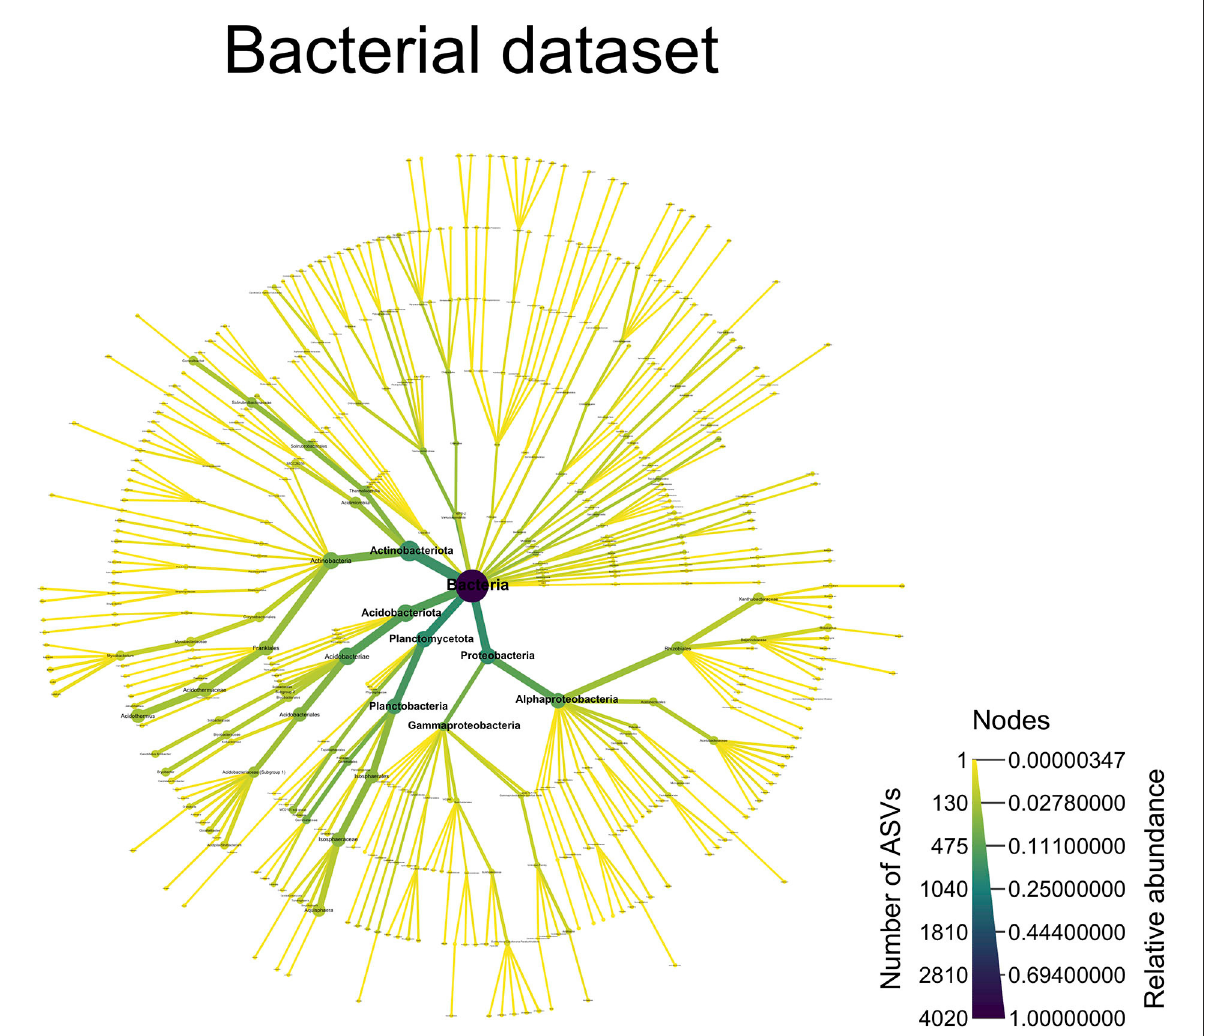
FIGURE6 A taxonomy overview of the bacterial community. This figure displays all of the bacterial ASVs, which were assigned to a taxonomic level [ASVs not assigned at a particular taxonomic level (NAs) are not shown]. The color of the edges and nodes indicates the number of ASVs found at a given taxonomic level, with darker color indicating more ASVs and lighter colors indicating fewer ASVs. The size of the edges and nodes indicates the relative abundance of the ASVs assigned to a particular taxonomic level, with wider edges/nodes indicating a high relative abundance and narrower edges/nodes indicating a low relative